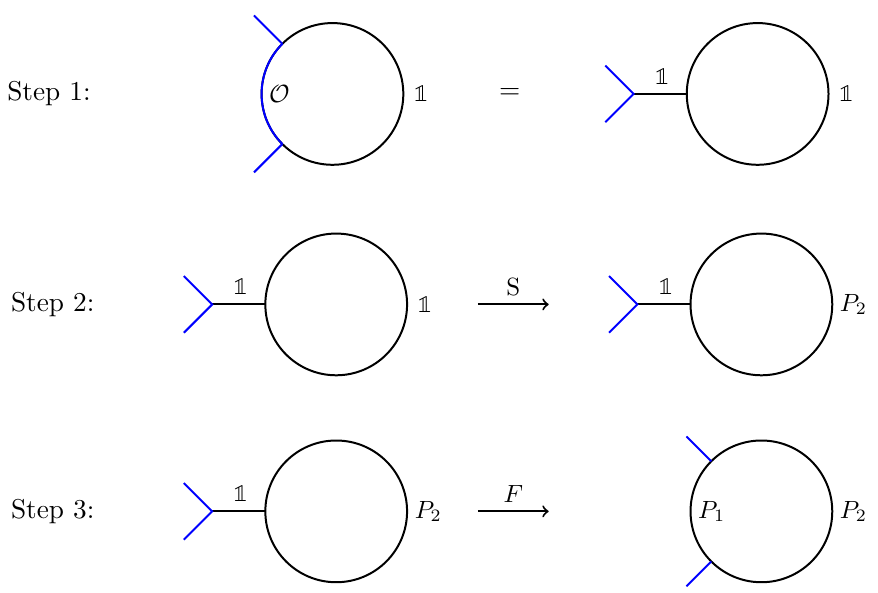
Figure 2 . Diagram of the fusion and modular transformation that was used to compute the left moving vacuum torus block in the appropriate limit. In the top diagrams, the circle is a spatial circle, and in the bottom diagrams it is a Euclidean time circle; these are swapped by the S-transform in step